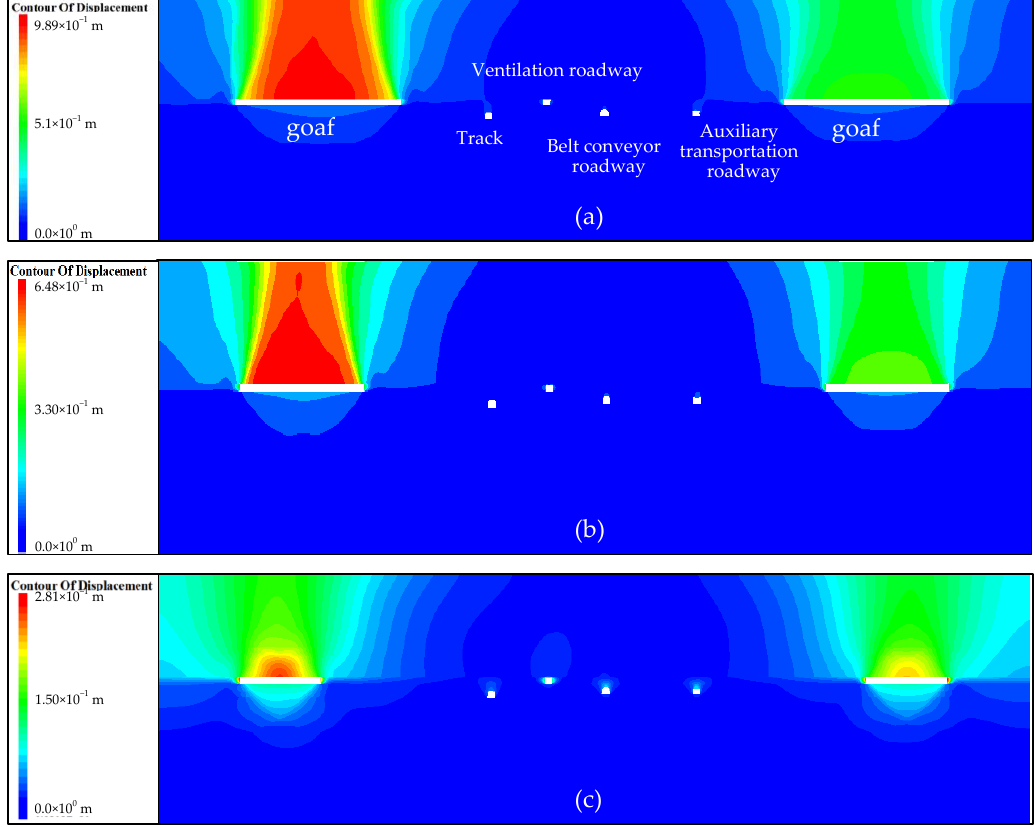
Figure 14. Vertical displacement diagram of different distances between working face and roadway: ( a ) 50 m, ( b ) 75 m, and ( c ) 100 m.